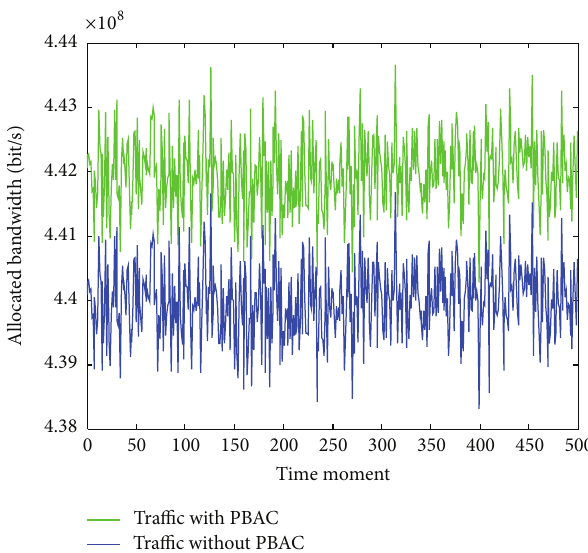
Figure 3: Simulation of allocated bandwidth of the applied method PBAC and without applied PBAC